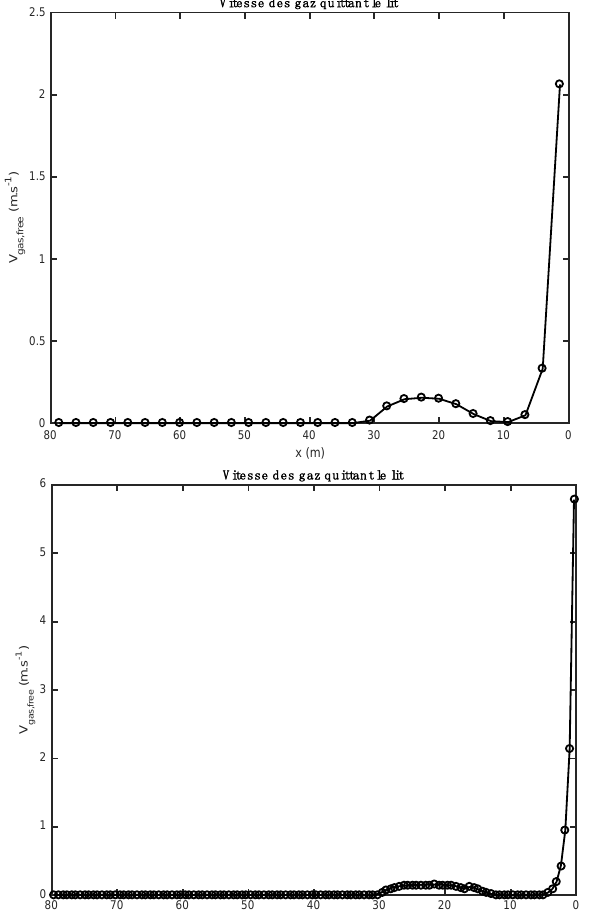
Figure 8. Comparison of the gas velocity profiles obtained with 30 (above) et 120 (below) compute nodes (heavy fuel oil and biomass).